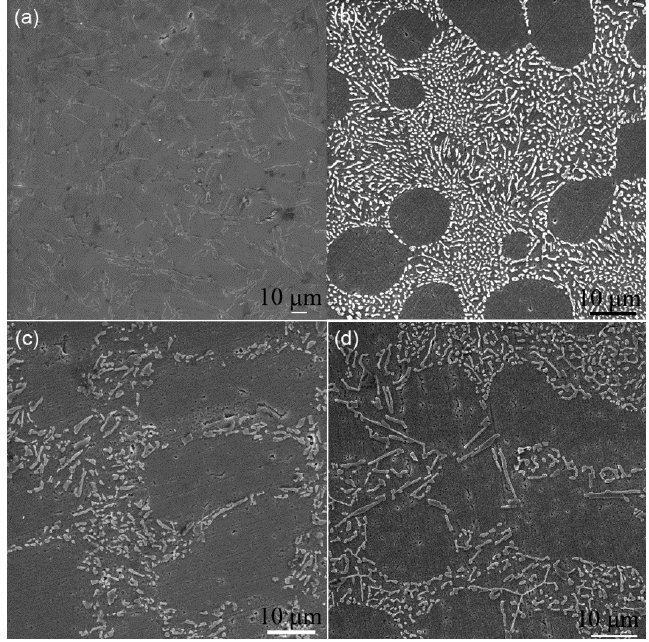
Figure 2. Microstructure of Al-Si base and modified alloys. ( a ) Base alloy. ( b ) Al–10Si–0.015Sr. ( c )